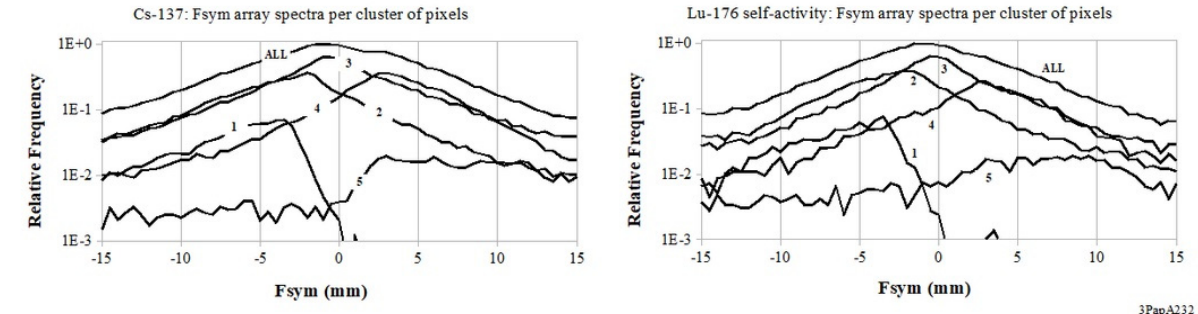
Figure 7. Fsym spectra per cluster of pixels from Cs-137 ( left ), and Lu-176 self-activity ( right ) data. All event spectra of the array are drawn (topmost curves) together with the ones of individual clusters from 1 to 5, represented, respectively, from left to right. Bin-sizes are of 1.6-, and 1.2-mm, respectively.